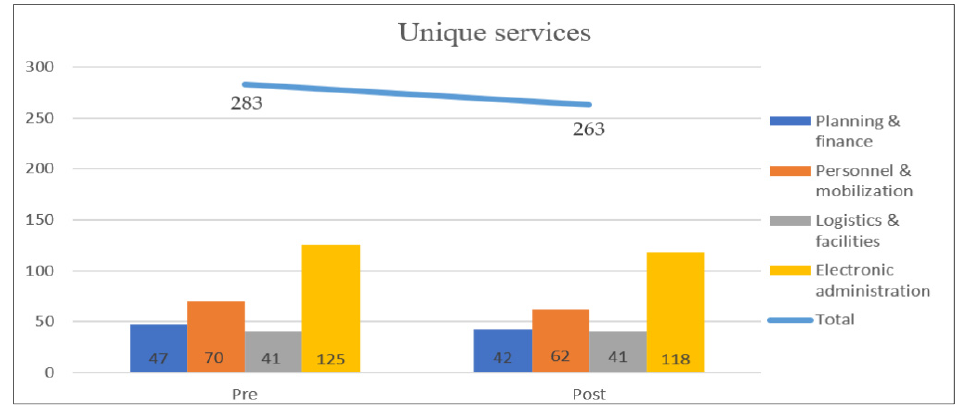
Figure 8. Unique services after applying MSF .